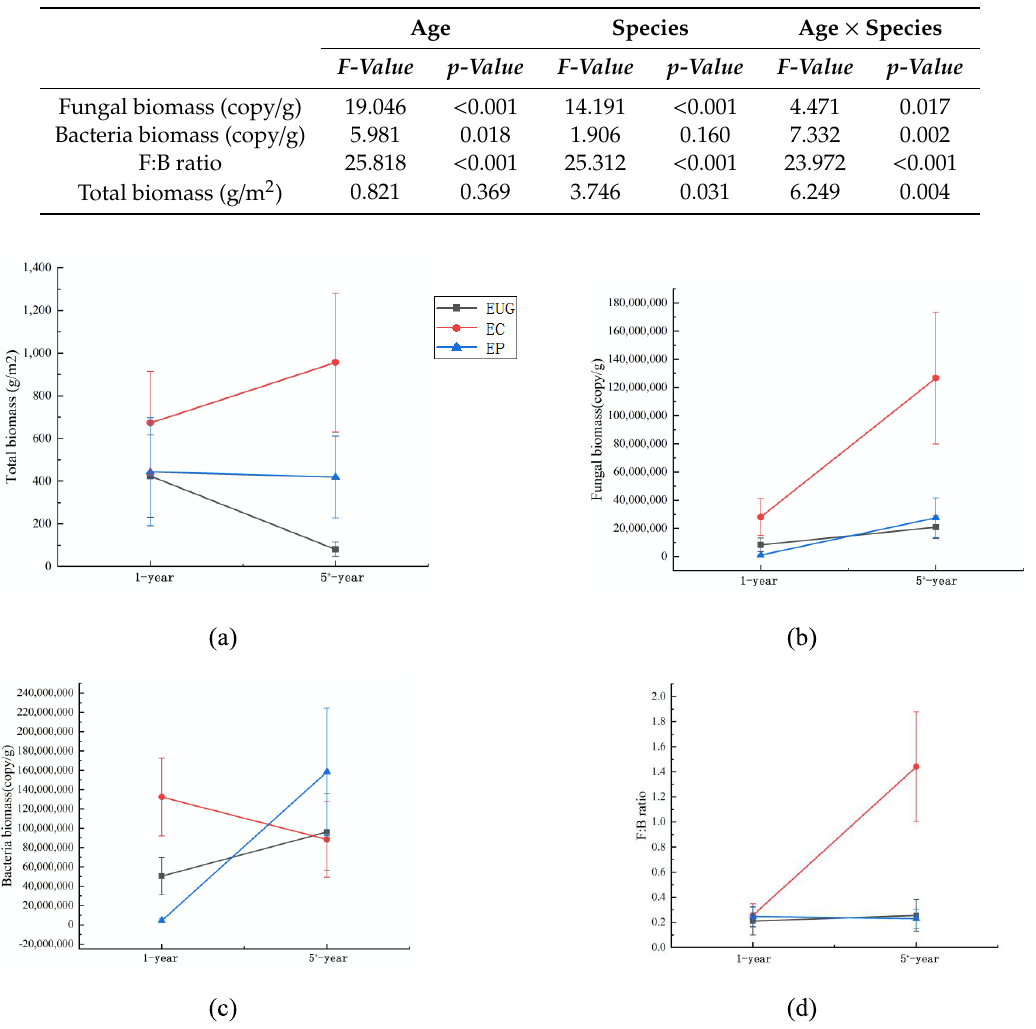
Table 1. Two-way ANOVA analysis showing the differences in soil microbial biomass, fungal and bacterial biomass, and fungi:bacteria ratio (F:B) between plantations.